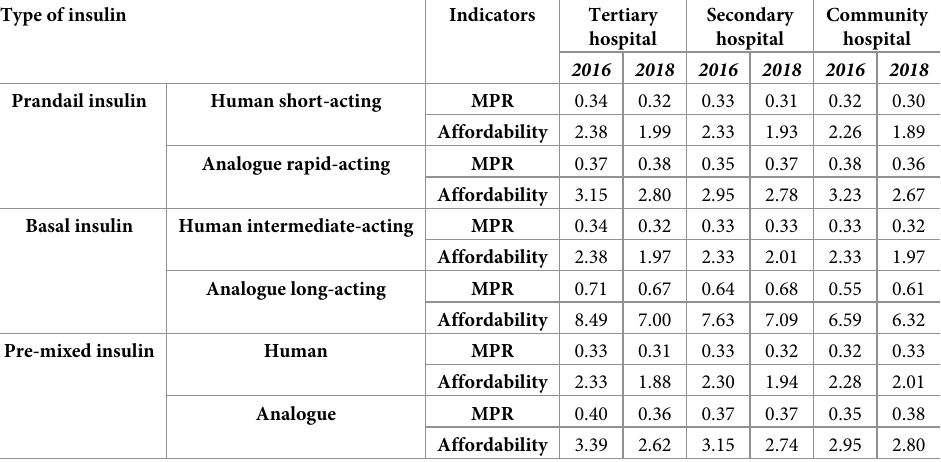
Table 8. Median Price Ratio (MPR) and average affordability of insulin in different-level of pharmacies. Type of